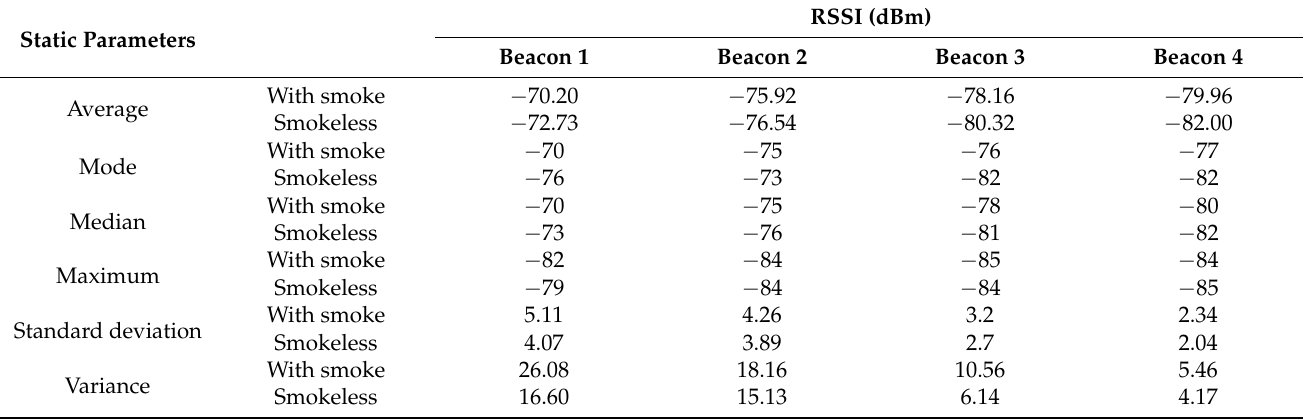
Figure 13. Pictures made during the evaluation in the CUS with the Teresa firefighter teams. Table 4. RSSI statistical parameters per